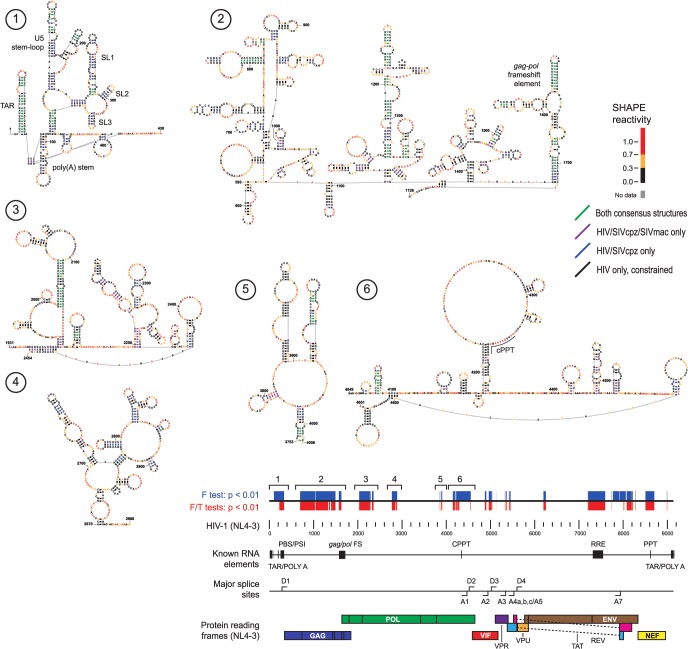
Secondary structure models for six structurally conserved elements in the 5' half of HIV-related RNA genomes.Nucleotides are colored by HIV-1 SHAPE reactivities. Secondary structures are shown for the final constrained HIV-1 secondary structure model. Base pairs are colored by level of structural consensus; black base pairs appear only in constrained HIV-1 predictions. Positions of predicted elements are shown on the HIV-1 (NL4-3) genome; annotations indicate statistical dependence, known RNA elements, major splice sites, and protein reading frames.